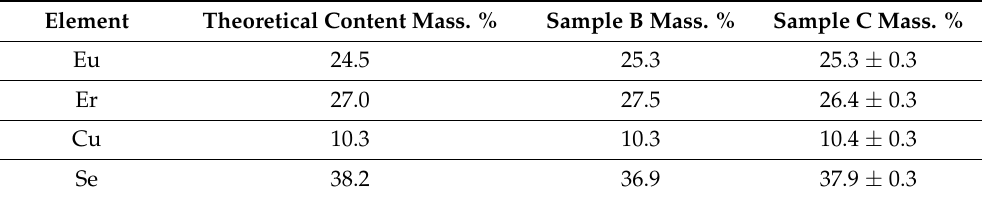
Figure 4. SEM patterns of EuErCuSe 3 particles ( a ), element mapping in the sintered EuErCuSe 3 powder ( b ), and constituent element maps ( c ), recorded in the polished EuErCuSe 3 sample, annealed at 1073 K. Table 3. Theoretical (B) and experimental (C) (according to the SEM data) contents of chemical elements in the EuErCuSe 3